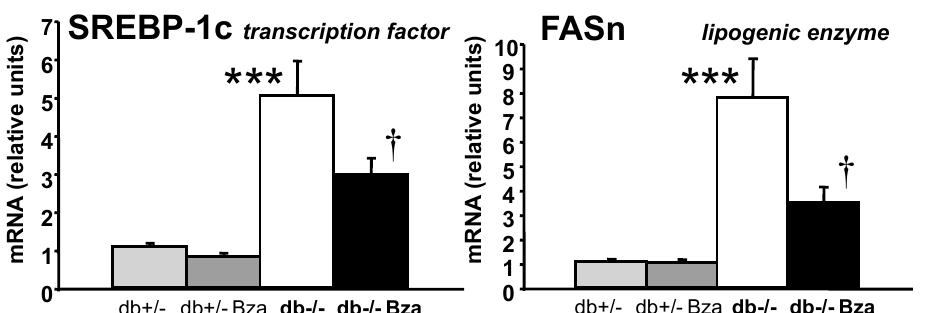
Figure 6. Normalization by benzylamine supplementation of the altered expression of several fuel metabolism- and inflammation-related genes in obese/diabetic mice. Upper panel: mRNA abun- dance of the adipokine apelin and of the macrophage marker F4/80 in SCWAT. mRNA abundance of the transcription factor SREBP-1C and of the lipogenic enzyme FASn in liver. Means ± SEM of 7–10 mice/group. Influence of genotype significant at: * p < 0.05; *** p < 0.001 for db-/- vs.